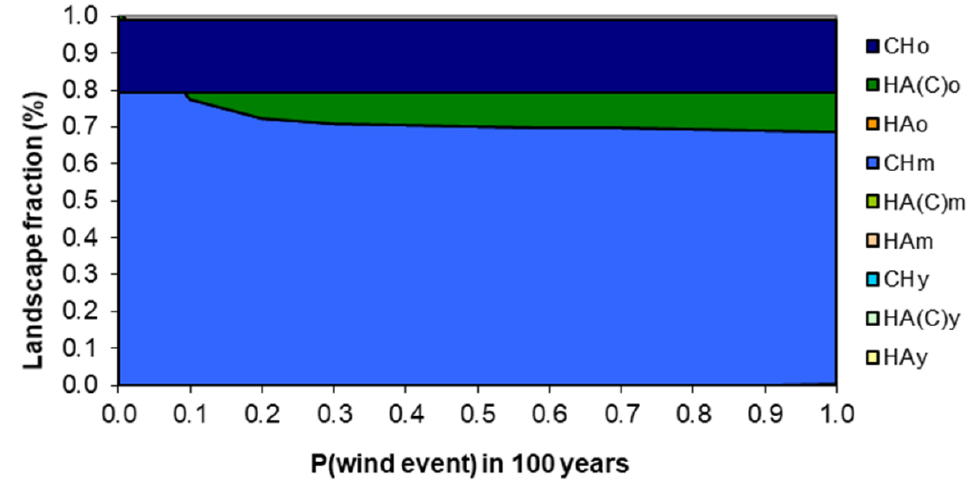
Figure 6. Landscape fraction (%) occupied by different stand types with the Markov chain model calibrated to follow the Clementsian model after 3000 years (30 iterations) for different probabilities (return periods) of wind storms.